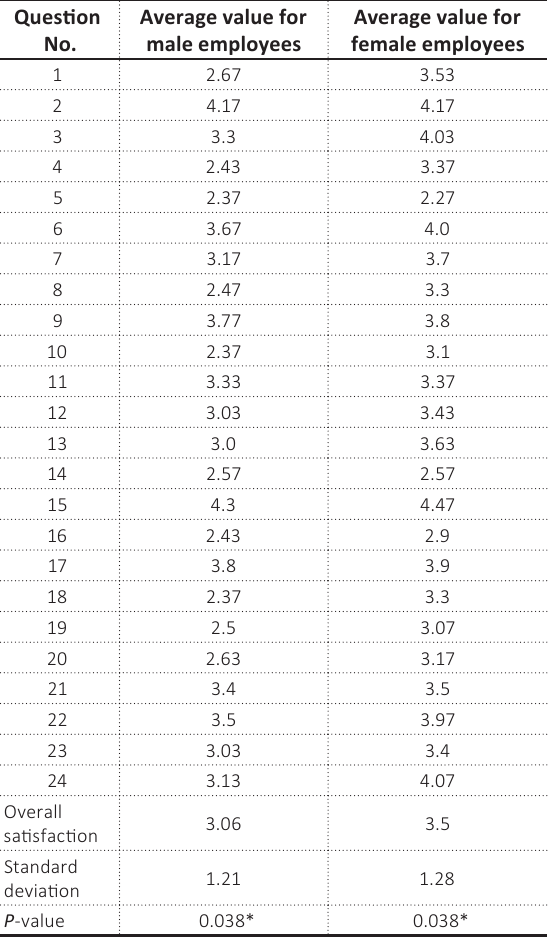
Table 6. Overall job satisfaction and gender